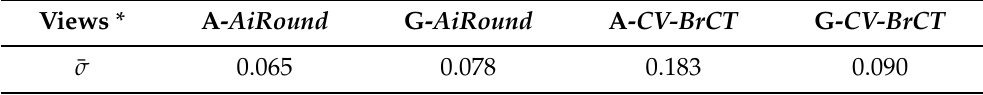
Table 1. The average error of the TEB-SUQ relative to subjective evaluation.